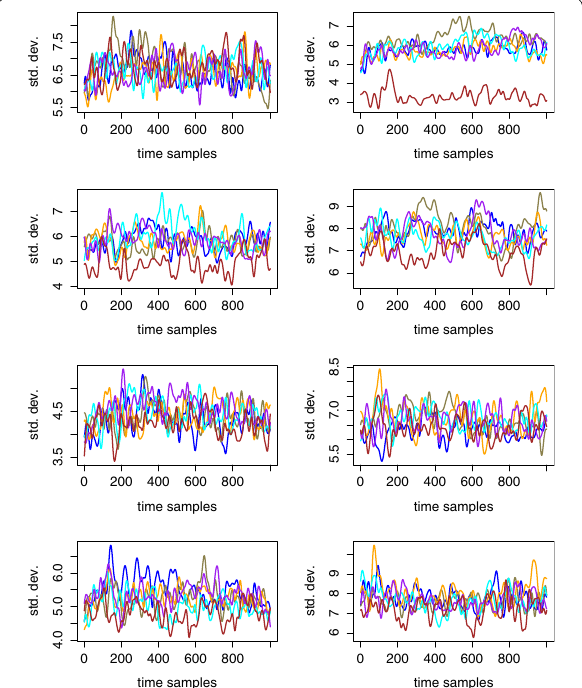
Fig. 15 Standard deviation traces for different tag values corresponding to Users 1, 3, 5 and 7 (left) and Users 2, 4, 6 and 8 (right), Electrode